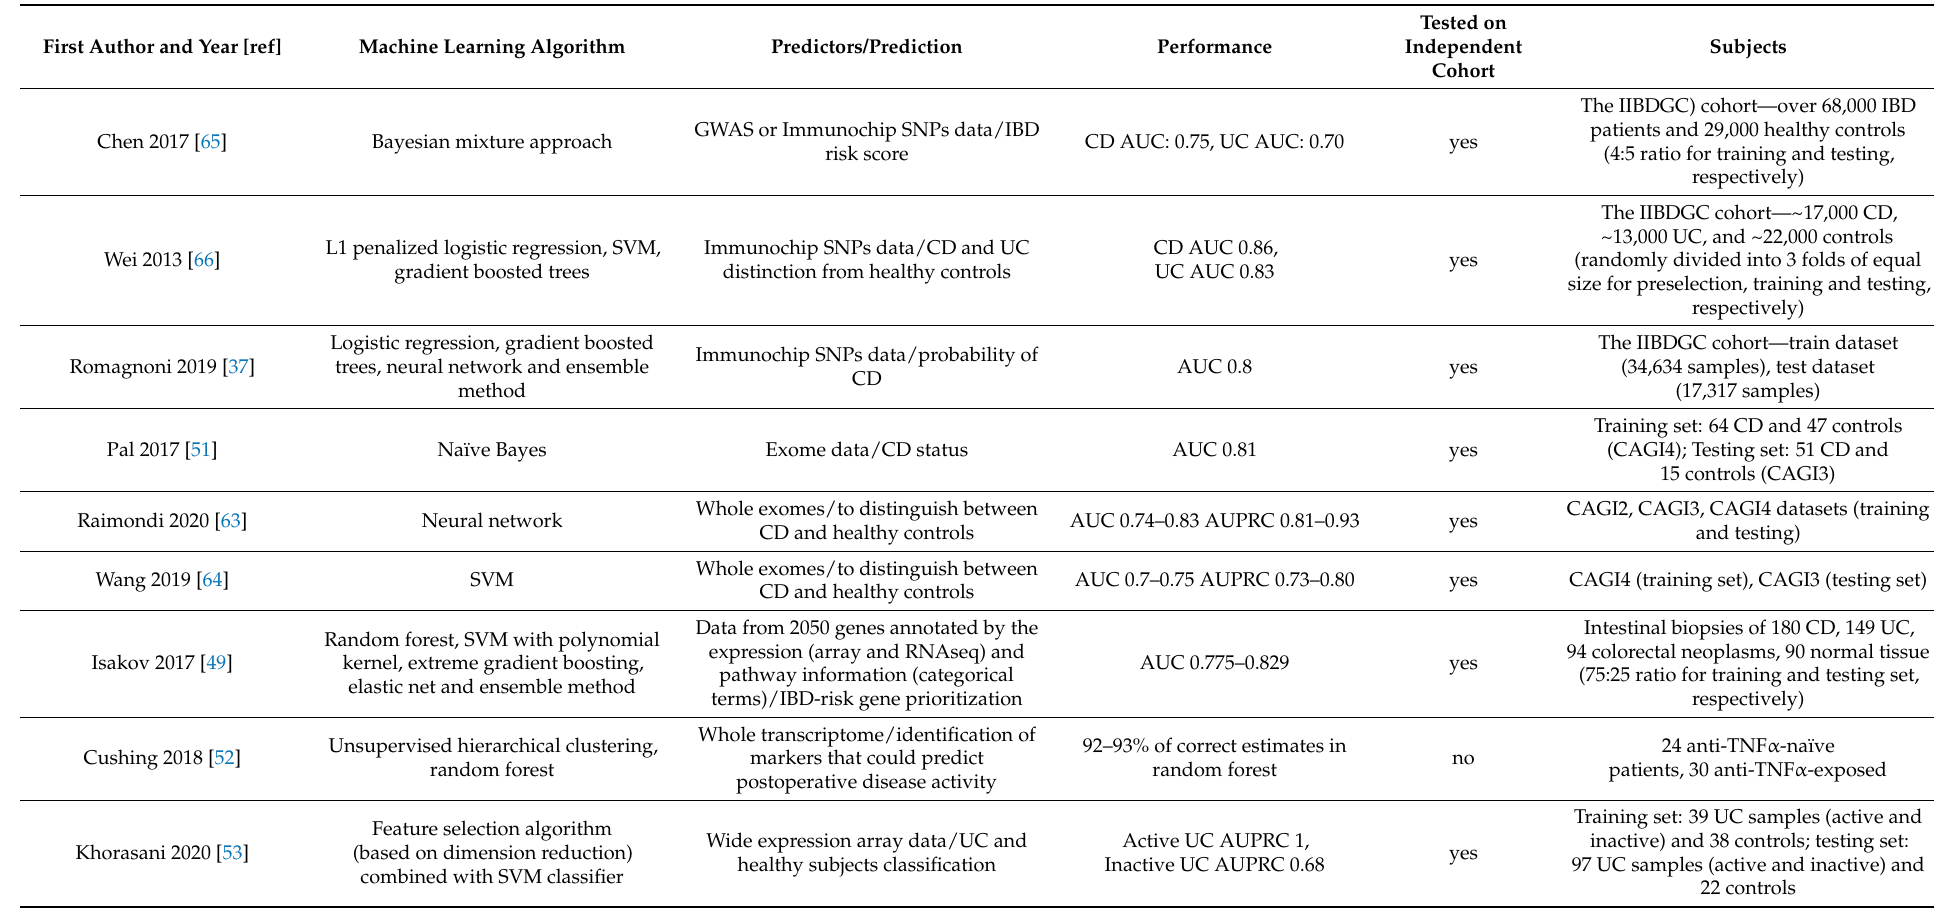
Table 3. Studies that explored machine learning for designing IBD prediction models using genomic and transcriptomic